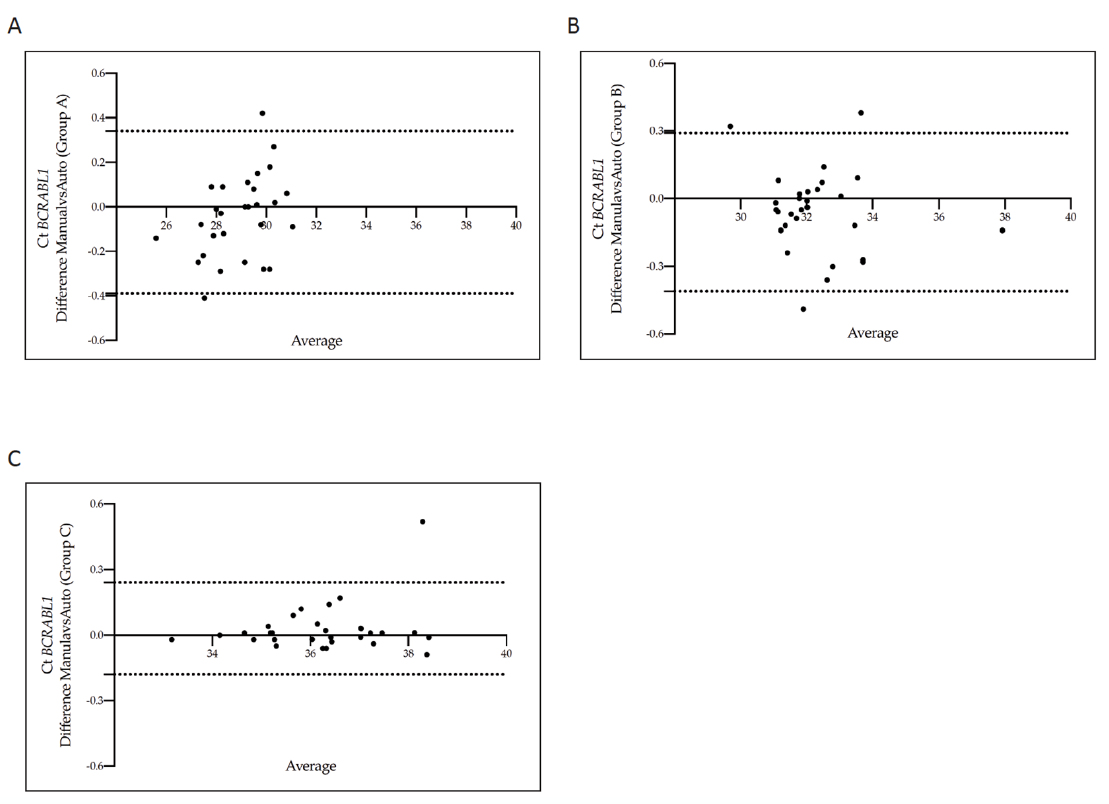
Figure 4. Bland–Altman showing the concordance of the BCR-ABL1 Cycle threshold values measured in matched samples counted by the manual and the automatic absolute cell-counting assay. Paired measurements of BCR-ABL1 Ct value were combined for patients stratified into three groups, each consisting of 30 individuals: Group A (10% > BCR-ABL1/ABL IS > 1%) ( A ), Group B (1% > BCR-ABL1/ABL1 IS > 0.1%) ( B ), and Group C (0.1% > BCR-ABL1/ABL IS > 0.01%) ( C ). The graph is plotted on the XY axis where X depicts the difference of the two measurements, and the Y-axis shows the mean of the two measurements. Horizontal lines are drawn at the mean difference between the two counting methods and the upper and lower limits of agreement. The 95% confidence intervals are shown for the mean and the upper and lower limits of agreement.